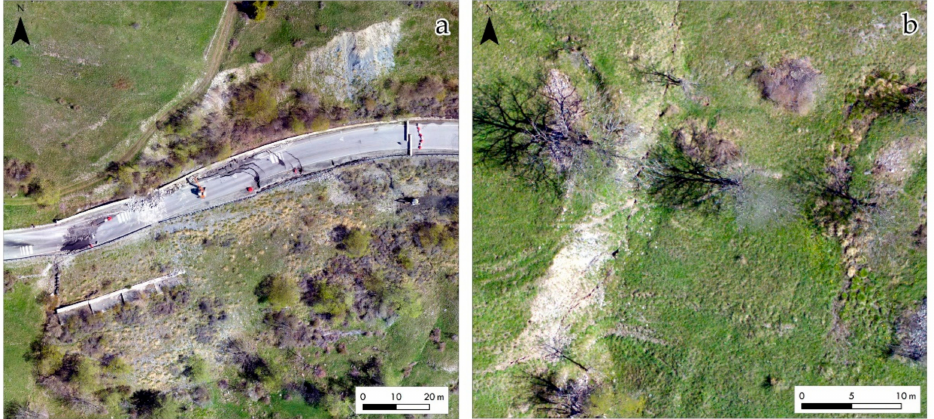
Figure 7. 15 May 2018 UAV orthoimage detail: ( a ) Main scarp of the crown area and road damage; ( b ) clearly visible latera fracture associated with a local fresh scarp, in the middle portion of the right-limit of the unstable area. On the right of the picture one of the wetlands is vividly